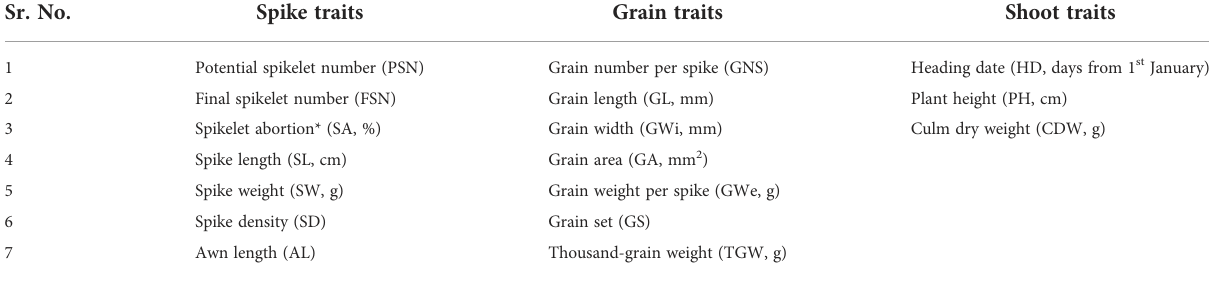
TABLE 1 List of spike, grain and shoot traits evaluated on a panel of 417 six-rowed barley accessions collected from across the globe. Sr.